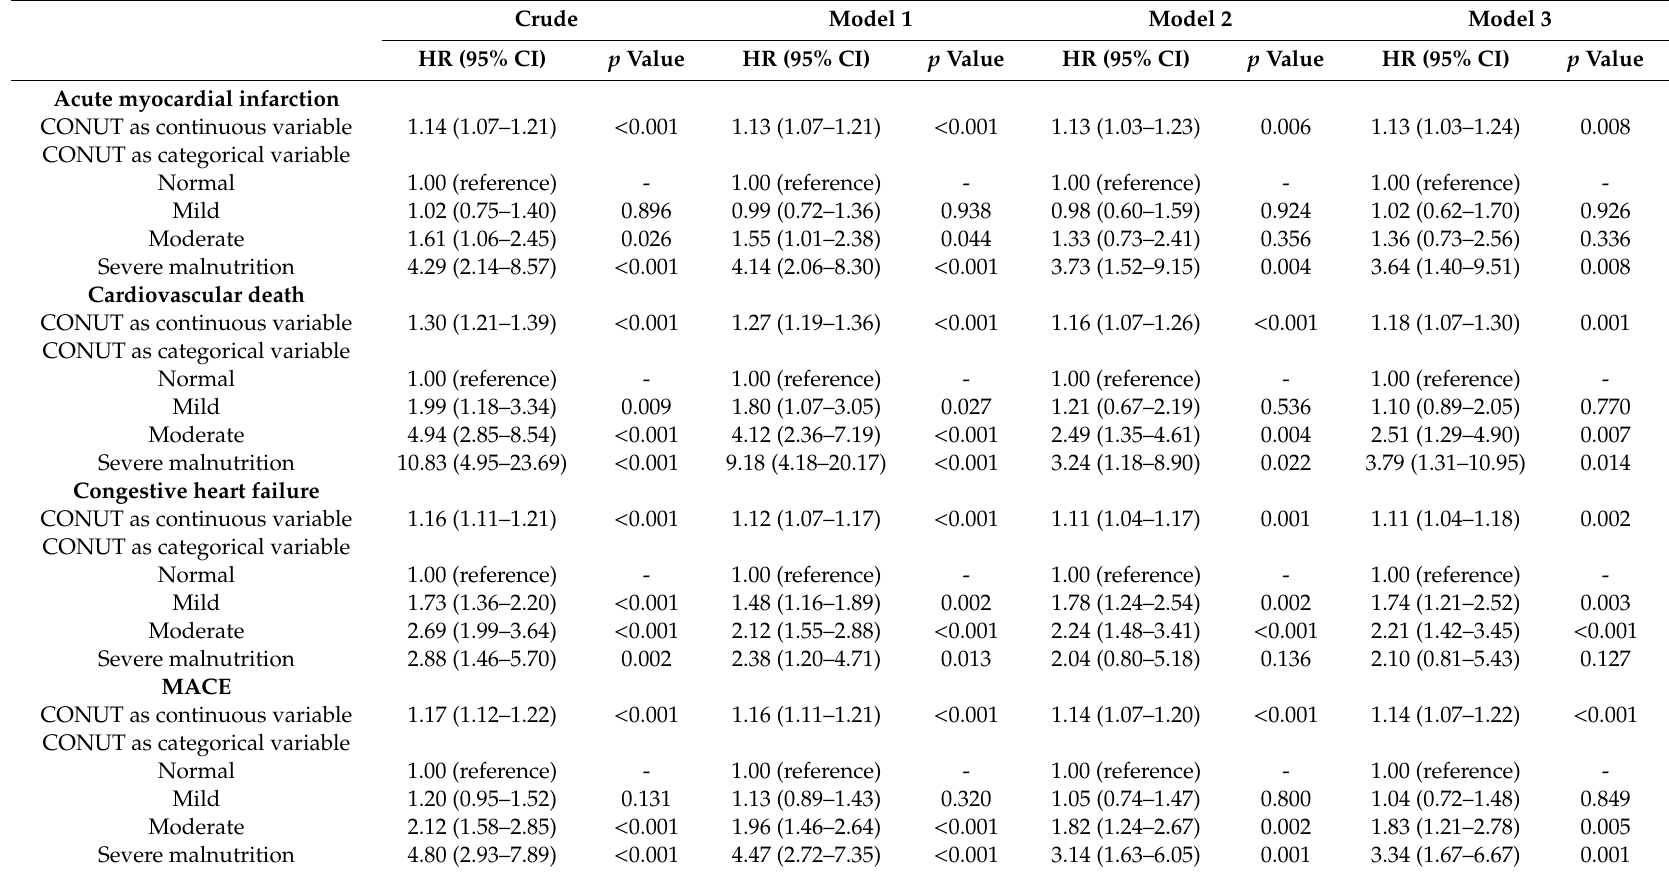
Table 3. Association of CONUT nutritional score and the clinical outcomes in di ff erent